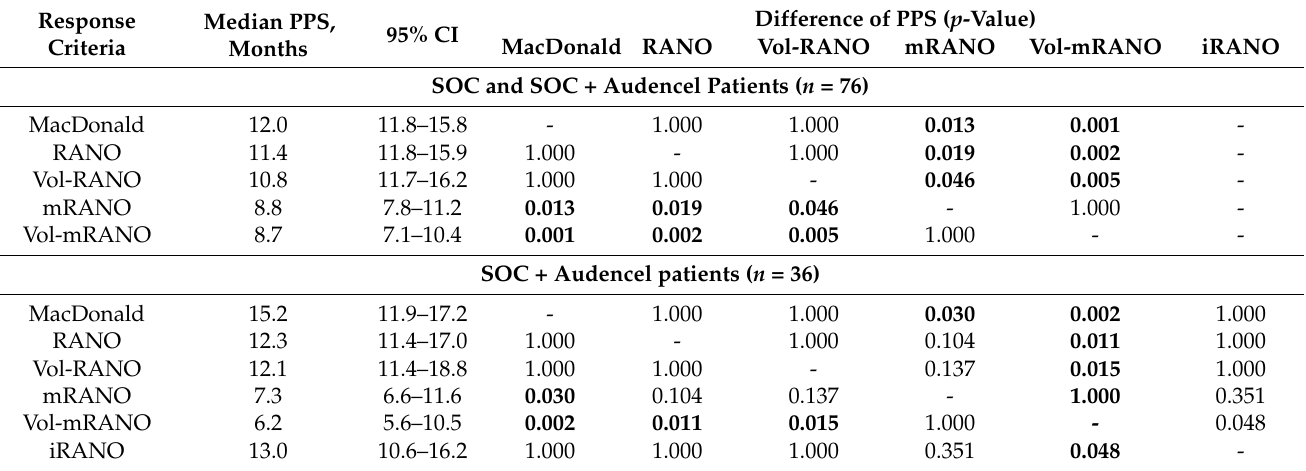
Table 4. Median postprogression survival with the corresponding confidence interval for the different assessment criteria. Calculated p -values (Kruskal–Wallis test) and corrected for multiple testing (Bonferroni’s adjustment) for difference in PPS between assessment